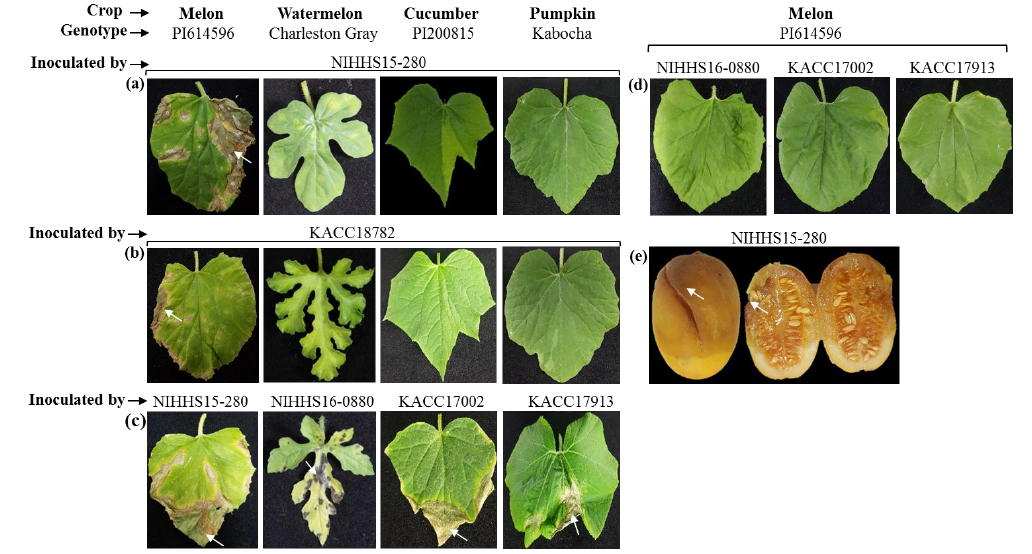
Figure 1. Melon, watermelon, cucumber, and pumpkin plants were inoculated with A. citrulli strains ( a ) NIHHS15-280, ( b ) KACC18782, ( c ) corresponding host, ( d ) melon with NIHHS16-088, KACC17002, and KACC17913 strains and ( e ) melon fruits with NIHHS15-280 strain. A. citrulli strains NIHHS15-280 and KACC18782 showing exclusively virulence towards melon leaves and fruits at 12 and 7 DAI respectively. Typical BFB symptoms are indicated by white arrows. All leaves and fruits were detached just before taking photographs.